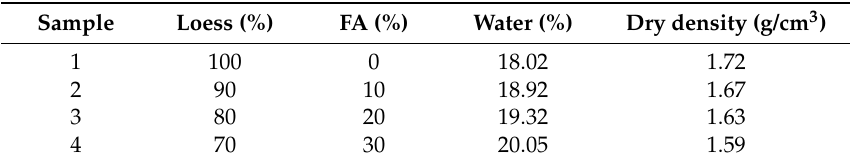
Table 4. Table containing the composition of